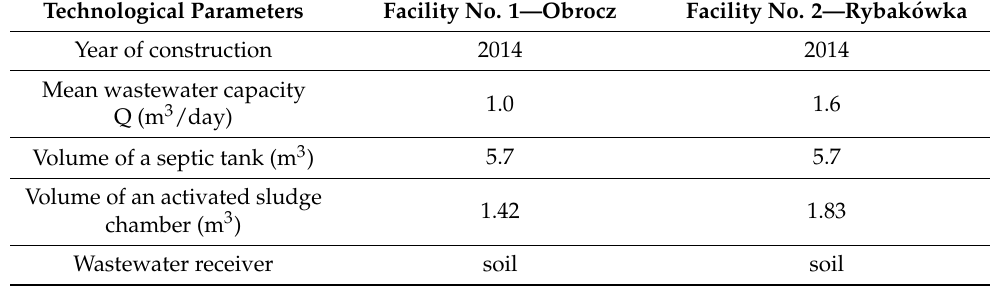
Table 1. Technological parameters of the household WWTPs in the area of the RNP. Technological Parameters